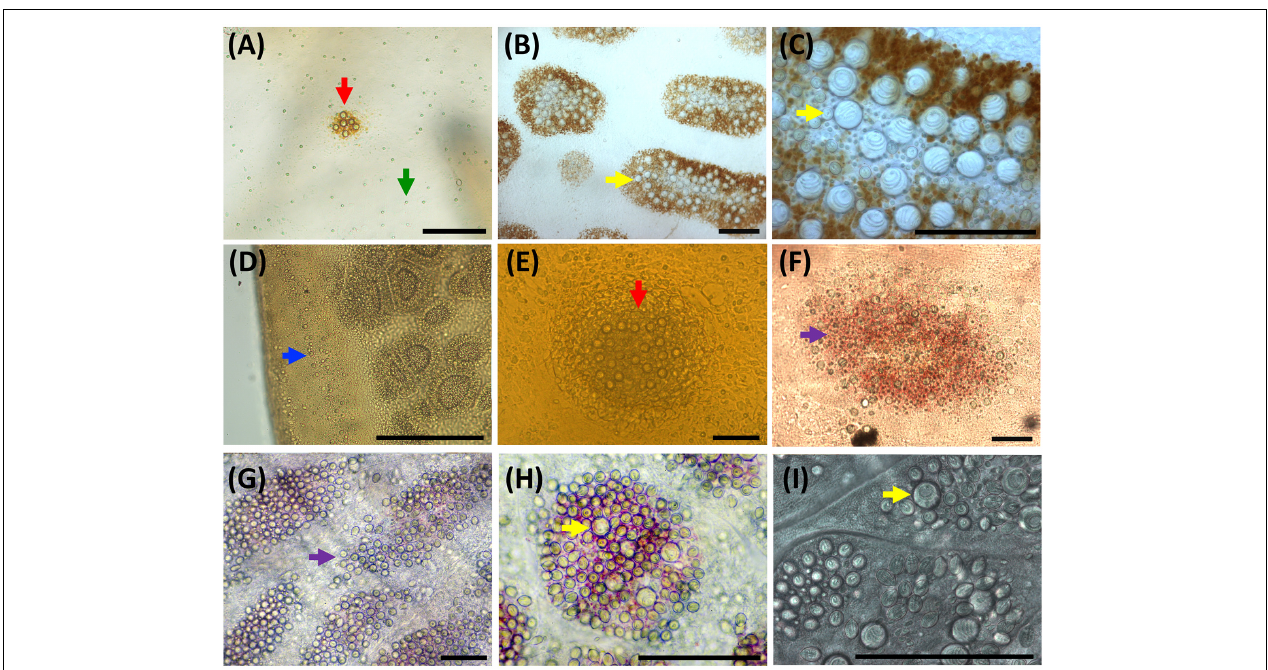
FIGURE 7 | Nematocyst clusters in different body parts. (A–C) Exumbrella. (D–F) Oral arms. (G–I) Marginal tentacles. (A) Abundant a-isorhizas (green arrow) randomly distributed despite initial nematocyst battery (red arrow) in metaephyra, stage 4. (B,C) Brown pigmented nematocyst batteries from adult medusa, stage 6. Note abundant O-isorhizas (yellow arrows). (D) Nematocyst line in rim of frilled oral margin (blue arrow) from juvenile medusa, stage 5. (E,F) Round (red arrow) to oval (violet arrow) nematocyst clusters in the oral groove from juvenile medusa, stage 5 (E) and adult medusa, stage 6 (F) . (G–I) Nematocyst batteries in marginal tentacles from adult medusa, stage 6. (G) Narrow to oval nematocyst batteries (violet arrow) with absence of large O-isorhizas. (H,I) Nematocyst batteries with presence of O-isorhizas (yellow arrows). Scale bars: 100 µ m. (G,H) photographed by Rubén